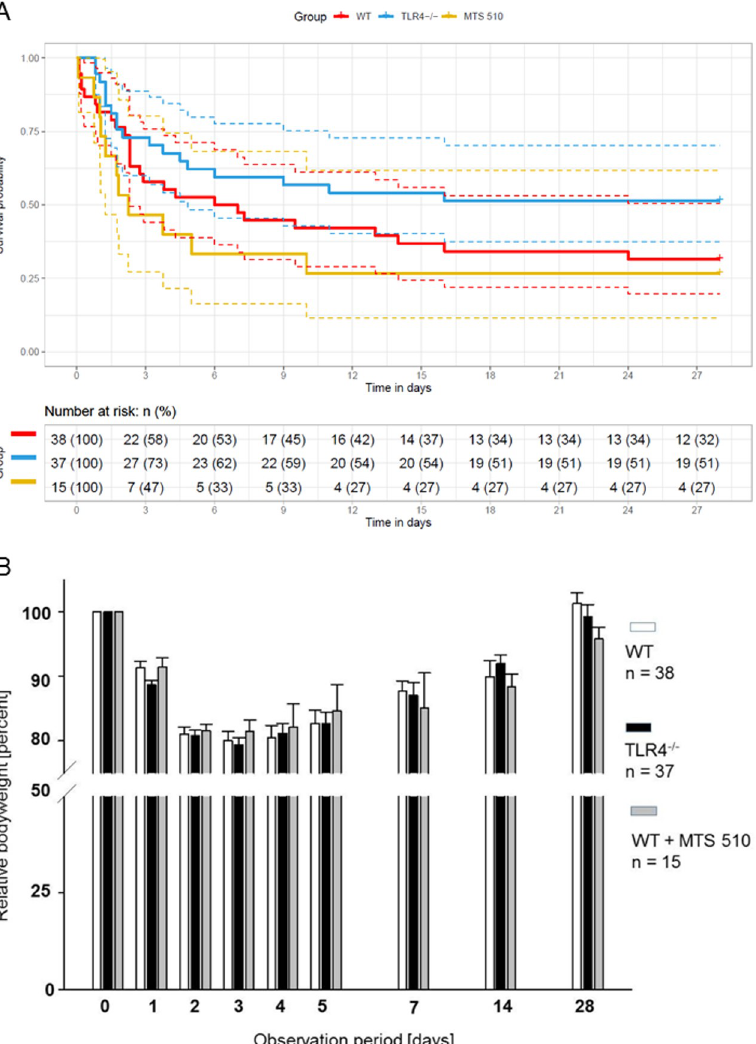
Fig 2. Survival and body weight over a 28 days observation period after CA/CPR. ( A) Kaplan-Meier plot for mouse survival after CA/CPR. Red, blue and yellow full lines denote the WT (n = 38 mice), TLR4 -/- (n = 37) and MTS 510 (n = 15) survival curves while the dashed lines represent their 95% confidence intervals. The survival table depicts the number and percentage of animals alive at three-day intervals for each of the groups. No significant differences between the groups were detected (P = 0.104 for the comparison of WT vs. TLR4 -/- and P = 0.423 for the comparison of WT vs. MTS510-treated WT mice). (B) Body weight of the three treatment groups after CA/CPR. There were no significant differences between groups at any point of